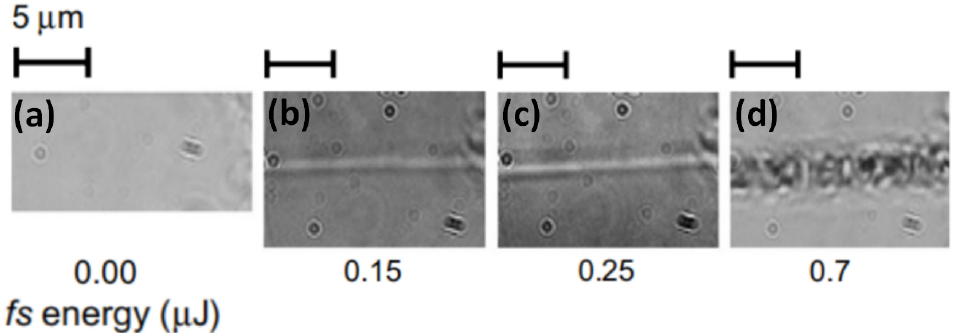
Figure 3. Glass modification examples. ( a ) unmodified material, ( b , c ) type I of glass modification or